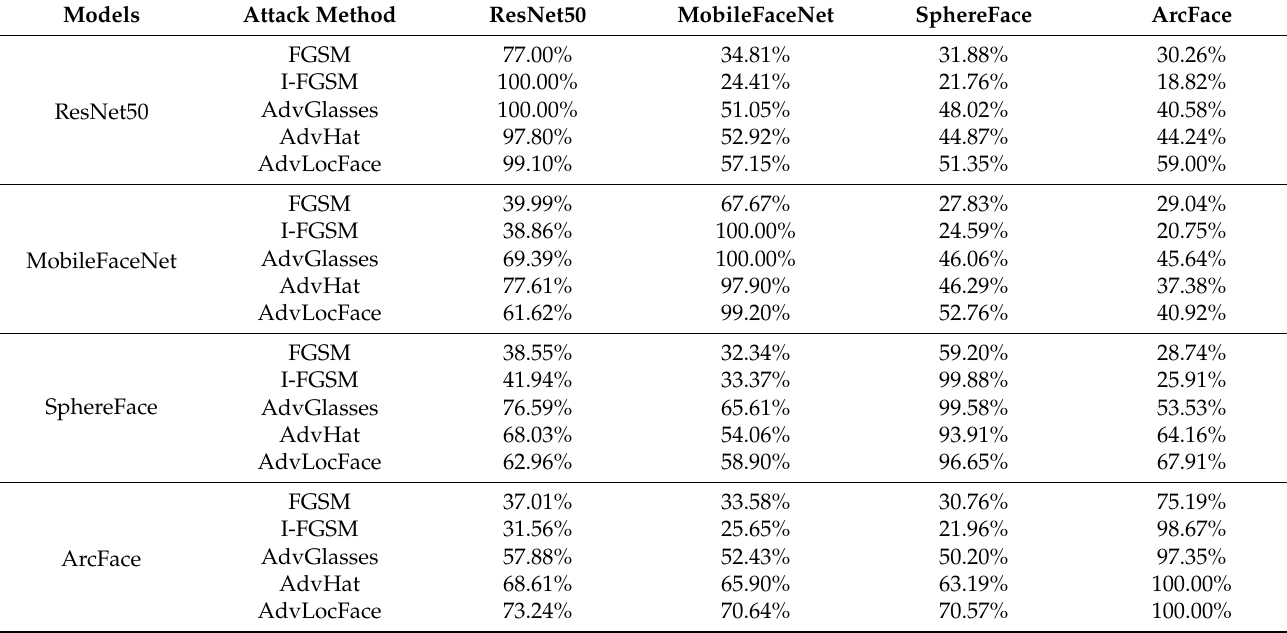
Table 4. Accuracy and success rates of different